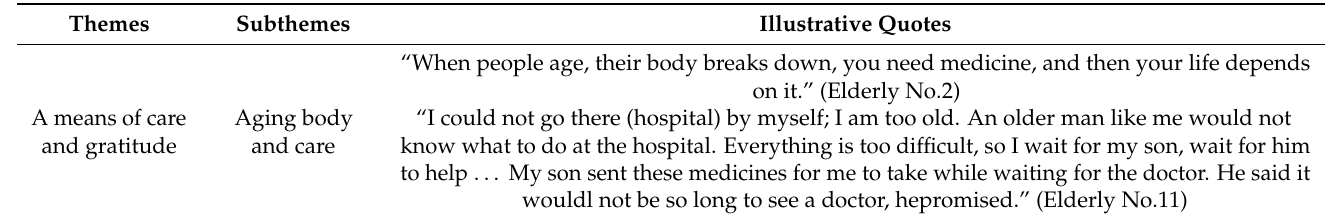
Table 3. Major themes and illustrative quotes identified through ethnographic